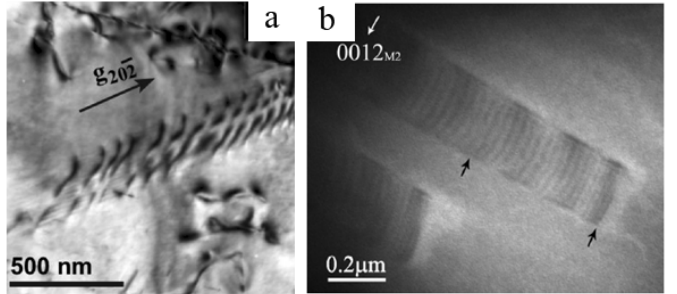
Figure 11. TEM image of dislocation pileups in front of micro-twins presented as “twinning dislocations”, ( a ) in an Fe–Mn–Si–Al Transformation Induced Plasticity (TRIP) steel, from [74]; and ( b ) in a tetragonal Ni–Mn–Ga alloy. Reprinted from [79] with permission from Elsevier.